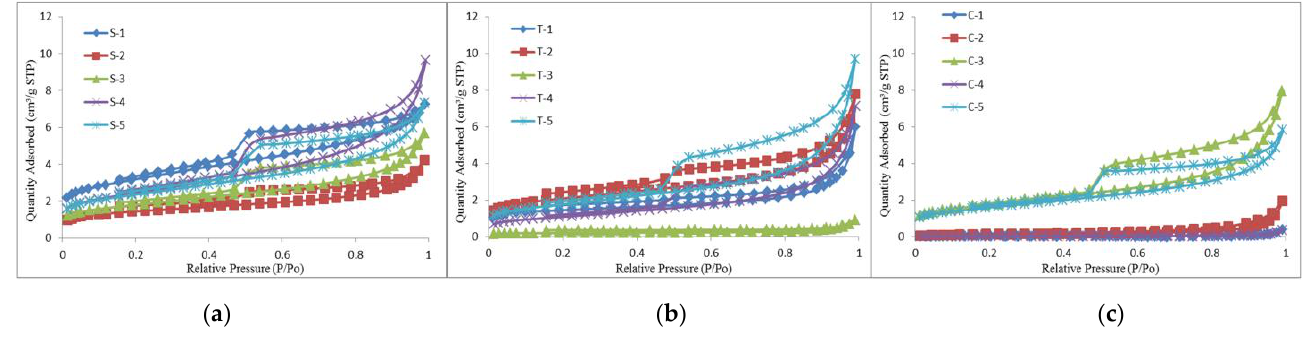
Figure 11. N 2 adsorption–desorption curves of shale, coal, and tight sandstone samples. ( a ) Shale samples. ( b ) Coal samples. ( c ) Tight sandstone samples.